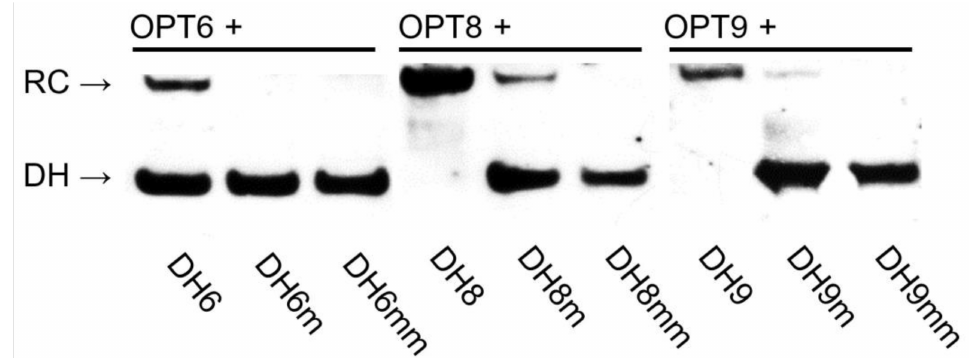
Figure 8. Representative electrophoretograms from recognition experiments in which a 100-fold molar excess of optimized Invader probes OPT6 , OPT8 , and OPT9 was incubated with the corresponding DNA hairpins featuring stems of identical sequence or differing in sequence at one (“m”) or two positions (“mm”) relative to the probes (37 ◦ C, 15 h). For sequences of DNA hairpins, see Table